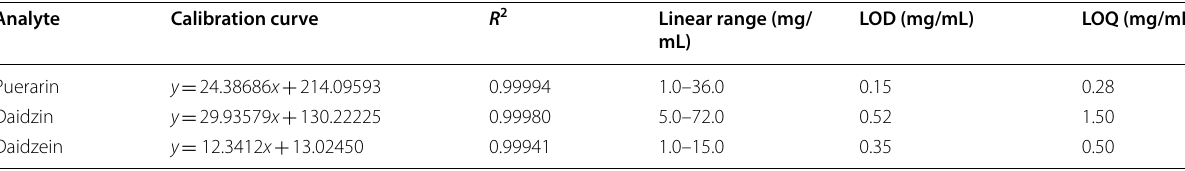
Table 1 Calibration curve analysis for puerarin, daidzin and daidzein Analyte